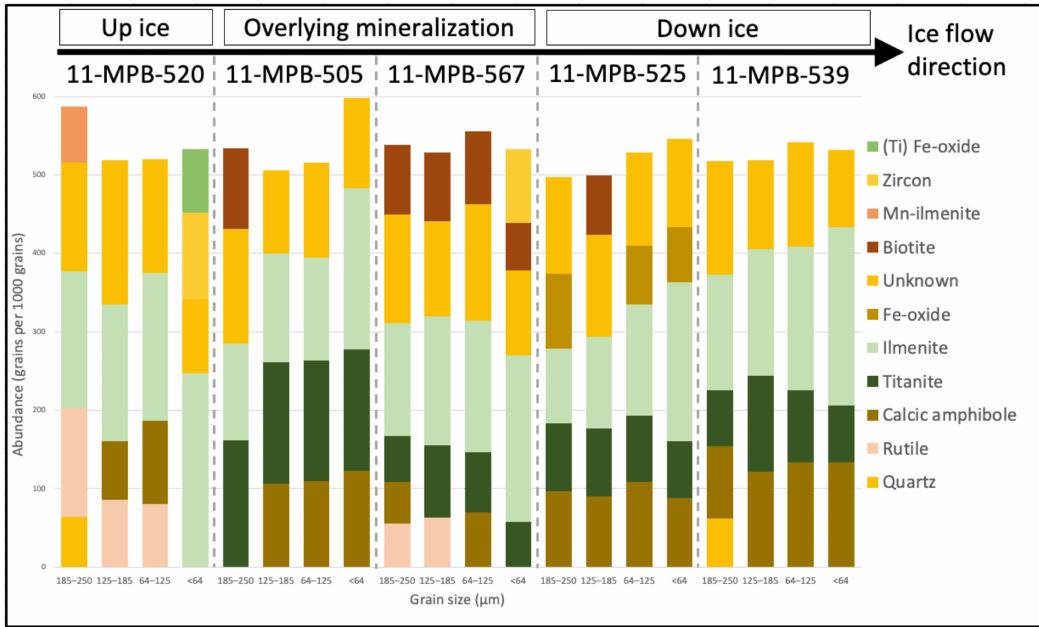
Figure 4. Mineral abundance (normalized to grains per 1000 grains) for the most abundant minerals comprising 50% of the less than 250 µ m fraction of till heavy-mineral concentrates, for the 185 to 250, 125 to 185, 64 to 125, and less than 64 µ m fractions of five till samples from the Sisson granite-hosted W-Mo deposit, New Brunswick. Labels above denote the position of each sample relative to massive sulfide mineralization, and the black arrow denotes the direction of ice flow. Sample locations relative to mineralization: 11-MPB-520: 4 km up ice; 11-MPB-567 and 11-MPB-505: overlying mineralization; 11-MPB-525: 4 km down ice; 11-MPB-539: 10 km down